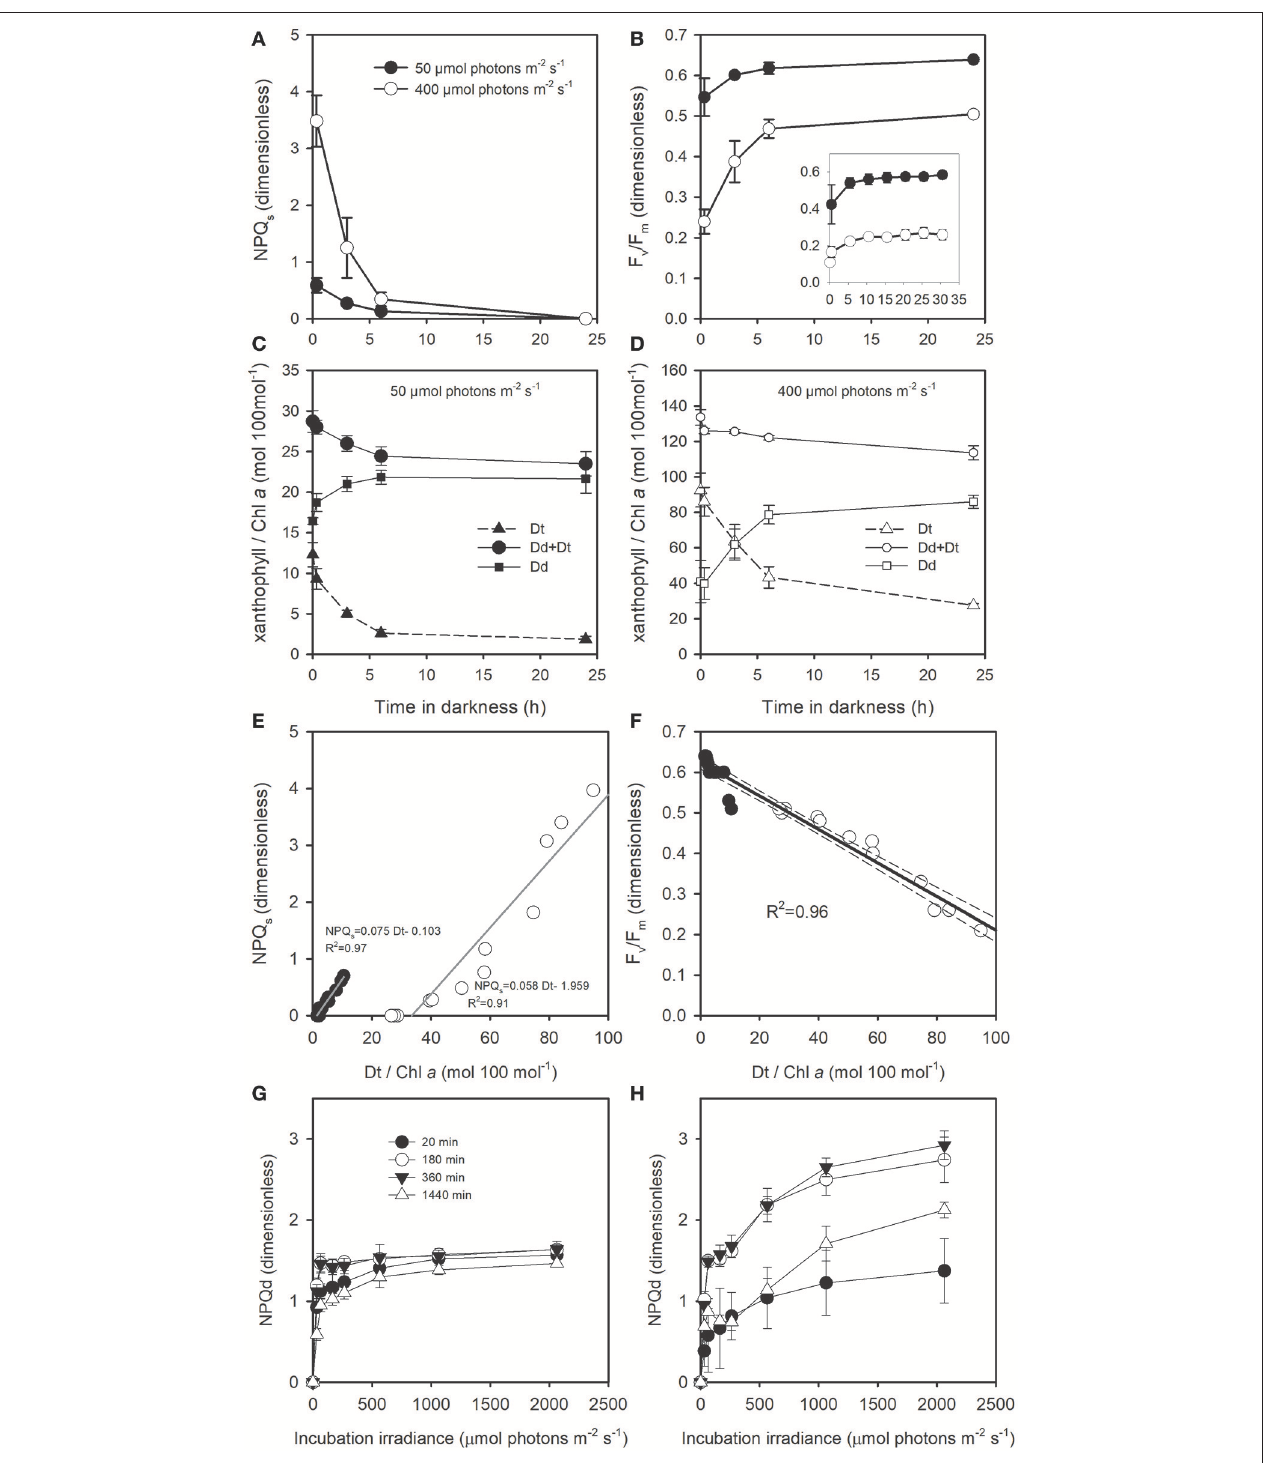
FIGURE 6 | Darkness time dependent change (A) in the sustained NPQ (NPQs), (B) in F v /F m , and in Dd and Dt content of T. gravida cells acclimated to 0 ◦ C and to growth irradiances (C) 50 µ mol photons m − 2 s − 1 and (D) 400 µ mol photons m − 2 s − 1 . (E,F) : relationship between Dt/Chl a and NPQs, and F v /F m , respectively; data are from (A–D) . In (A,B,E,F) , closed and open symbols represent cells acclimated to 50 and 400 µ mol photons m − 2 s − 1 , respectively. NPQd as a function of incubation irradiance in cell previously acclimated to (G) 50 µ mol photons m − 2 s − 1 and (H) 400 µ mol photons m − 2 s − 1 and after 20, 180, 360, and 1140min dark acclimation. Each data point is the mean of 3 independent cultures, error bars represent standard deviations.